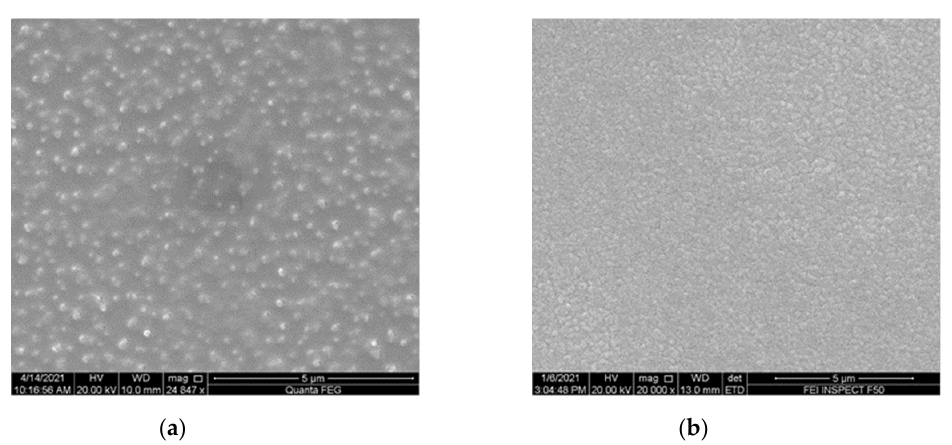
surface, which improved the performance of the QD-LED.